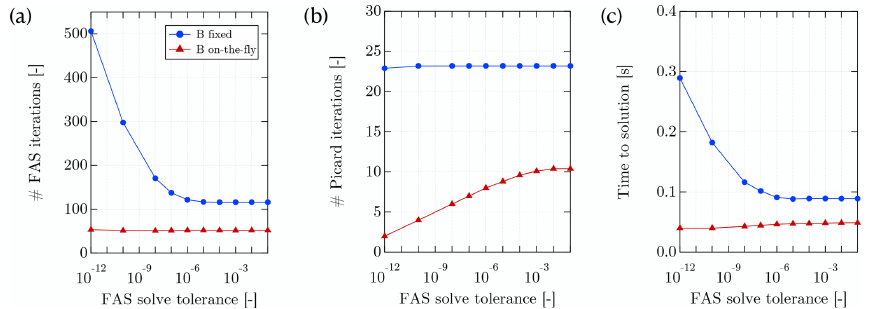
Figure C1. Average of the (a) number of FAS iterations, (b) number of Picard iterations and (c) total computational time required to complete one time step with SUHMO as a function of the FAS solve tolerance. The tolerance of the Picard iterations is held fixed at 10 − 8 .